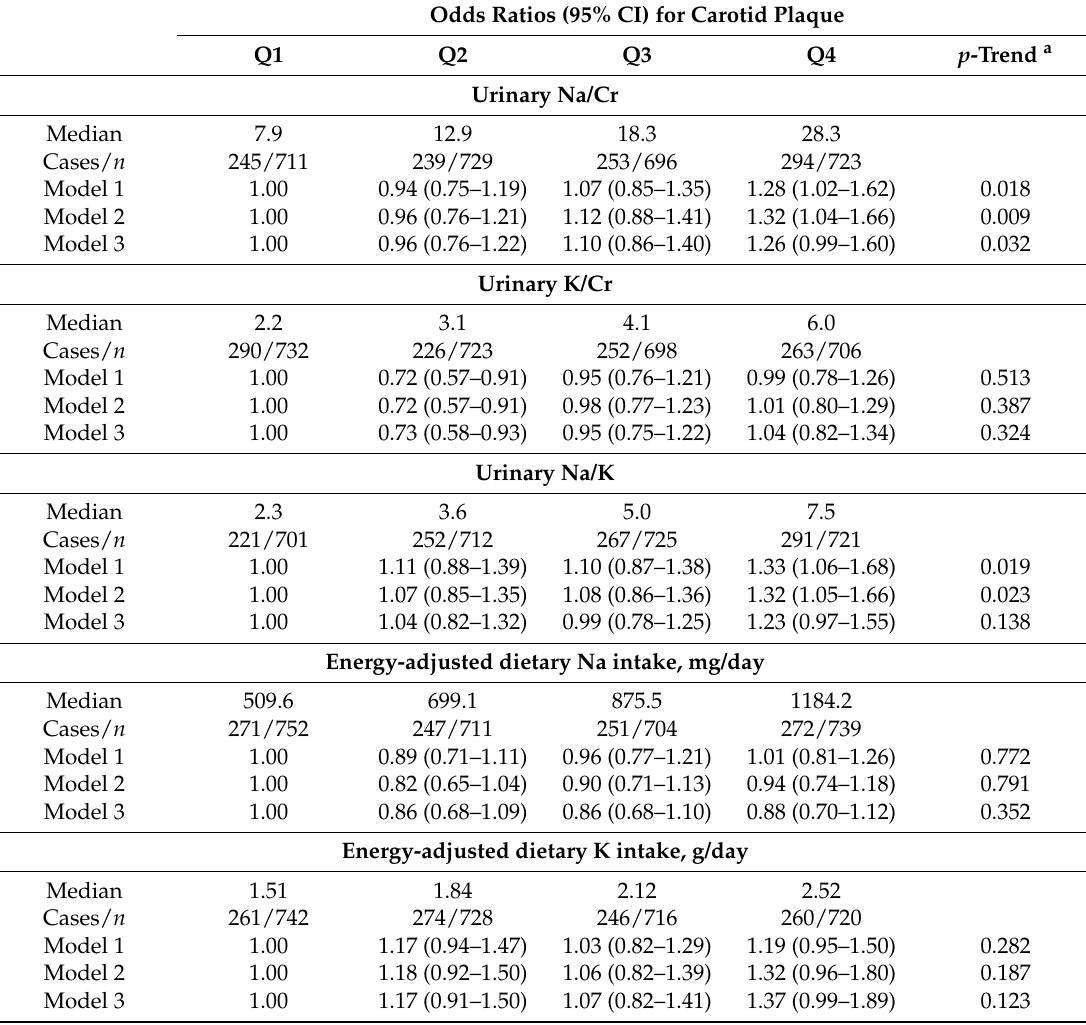
Table 2. Odds ratios and 95% CI for the prevalence of carotid plaque by quartiles (Q) of sodium (Na) and potassium (K). Odds Ratios (95% CI) for Carotid